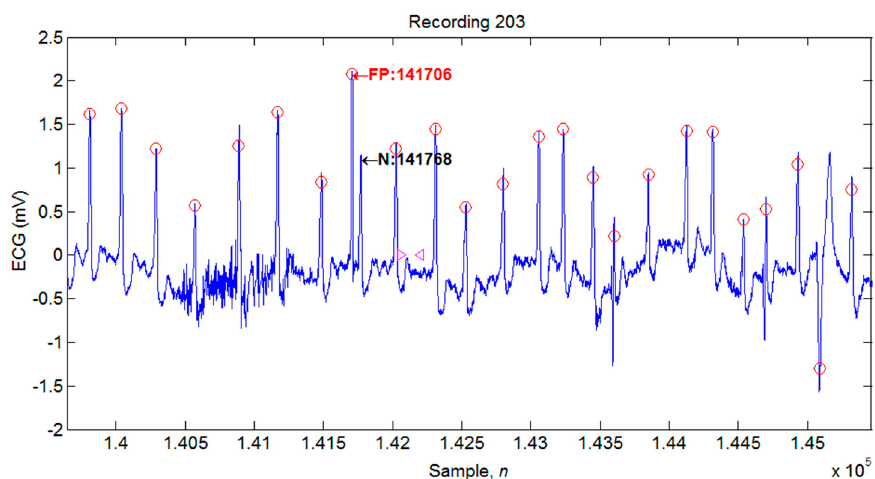
Figure 15. Illustration of the detection failure caused by the distance shorter than 100 samples between two successive QRS peaks.